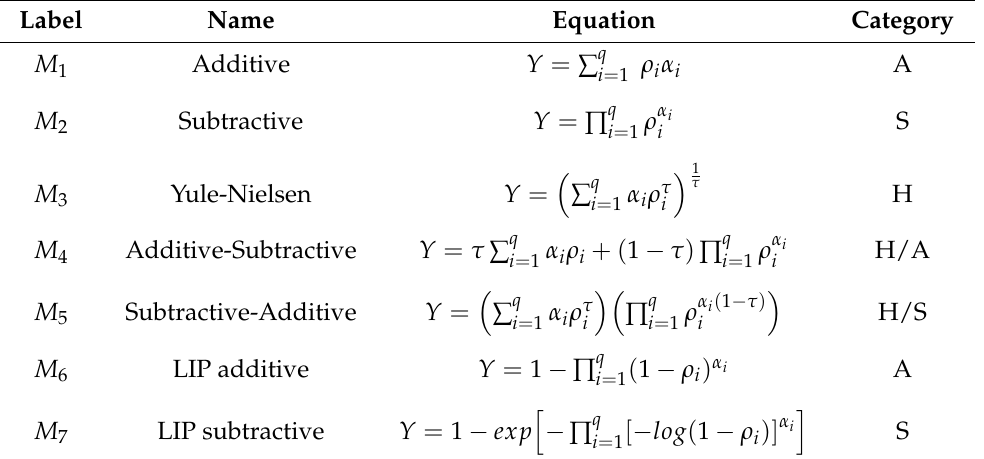
Table 1. Proposed imaging models divided into three main categories: additive (A), subtractive (S), and hybrid (H). The models M 4 and M 5 are indeed hybrid but have strong additive and subtractive tendencies,